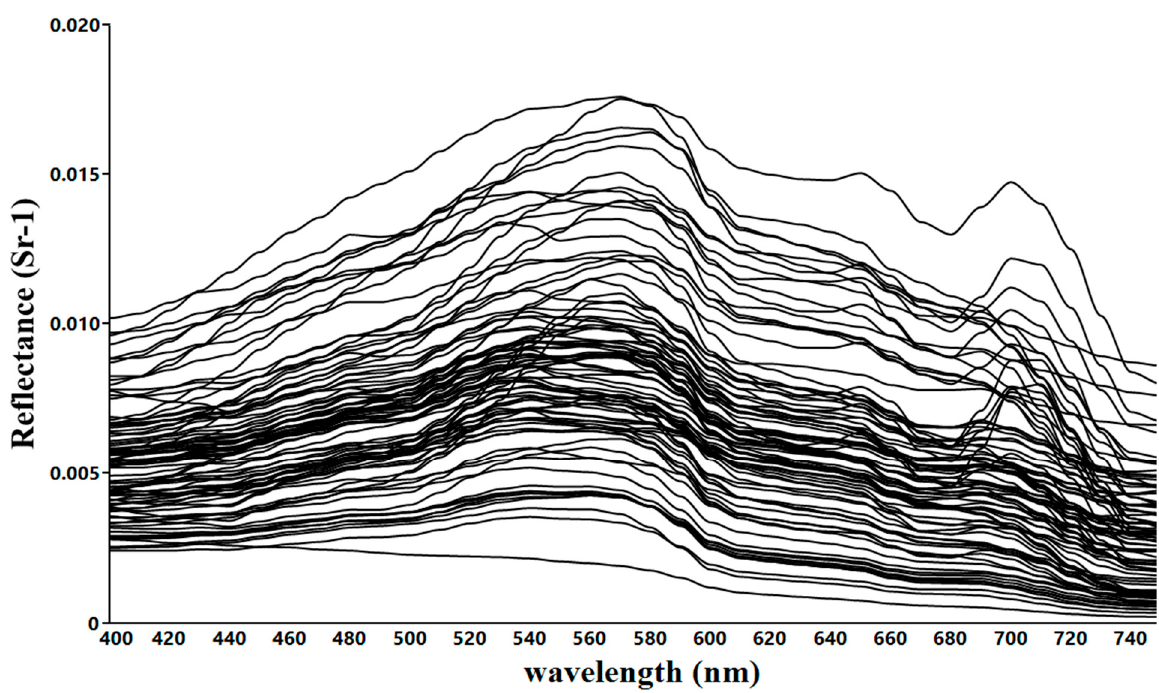
Figure 2. In situ reflectance spectra (400–750 nm) at 18 stations in the